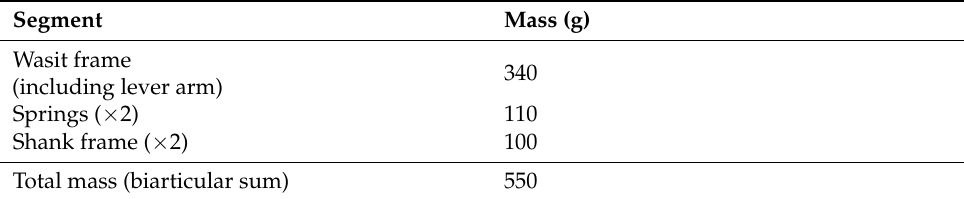
Table 1. The mass distribution of unpowered hip–knee